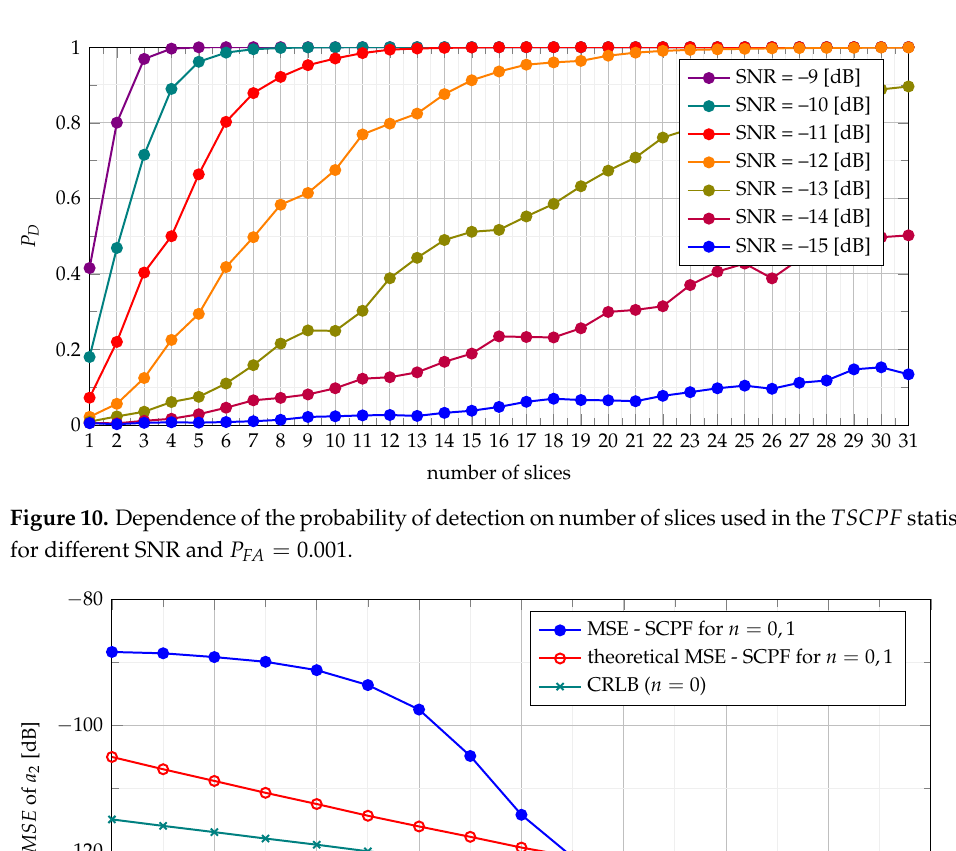
Figure 11. Theoretical and measured MSEs of the SCPF for n =